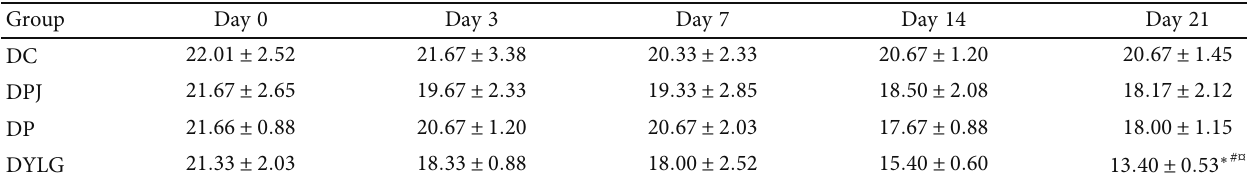
DC: diabetic control group; DPJ: diabetic negative control group; DPC: diabetic positive control group; DYLG: diabetic Yeliangen-treated group. ∗ p < 0 : 05 as compared to DC group, # p < 0 : 05 as compared to DPC group, and ¤ p < 0 : 05 as compared to DPJ group. The results were represented as mean ± SEM . ∗ The meaning of the symbols in the following tables is the same in this study, so they will not be repeated. Table 2: The serum glucose levels (mmol/l) in T2DM rats on days 0, 3, 7, 14, and 21 ( n = 24 per group). Group